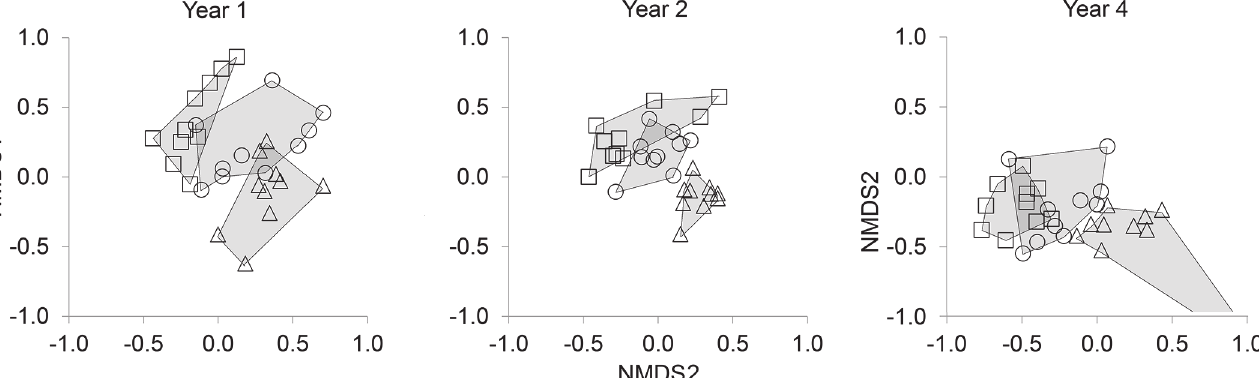
Fig 3. NMDS plots. The best two-dimensional NMDS solution of the difference in species assemblage. Each point represents one clear-cut and high stumps, logs and low stumps are denoted with squares, triangles, and circles respectively. Lines and shadows are drawn around each substrate type to the emphasize groupings. To be able to draw all plots on the same scale, one data point was left out in year. The 2D stress was